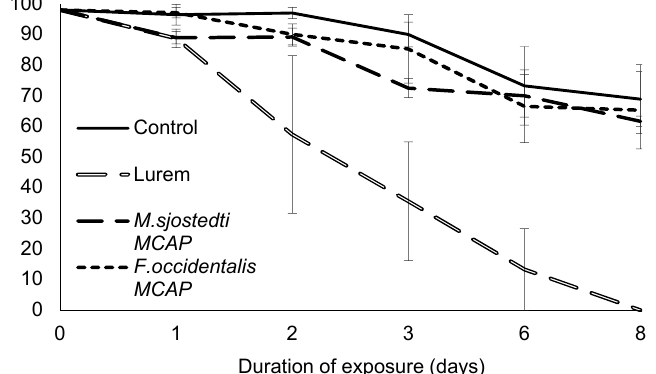
Figure 1. Effect of thrips aggregation pheromones and non-pheromone attractant on M. anisopliae conidial viability after 0 to 8 days of exposure at 30 µg dose per attractant. MCAP: major component of aggregation pheromones.